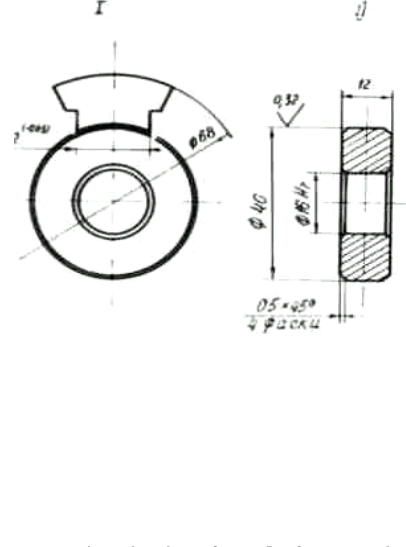
Fig.6 Sketches of samples for research